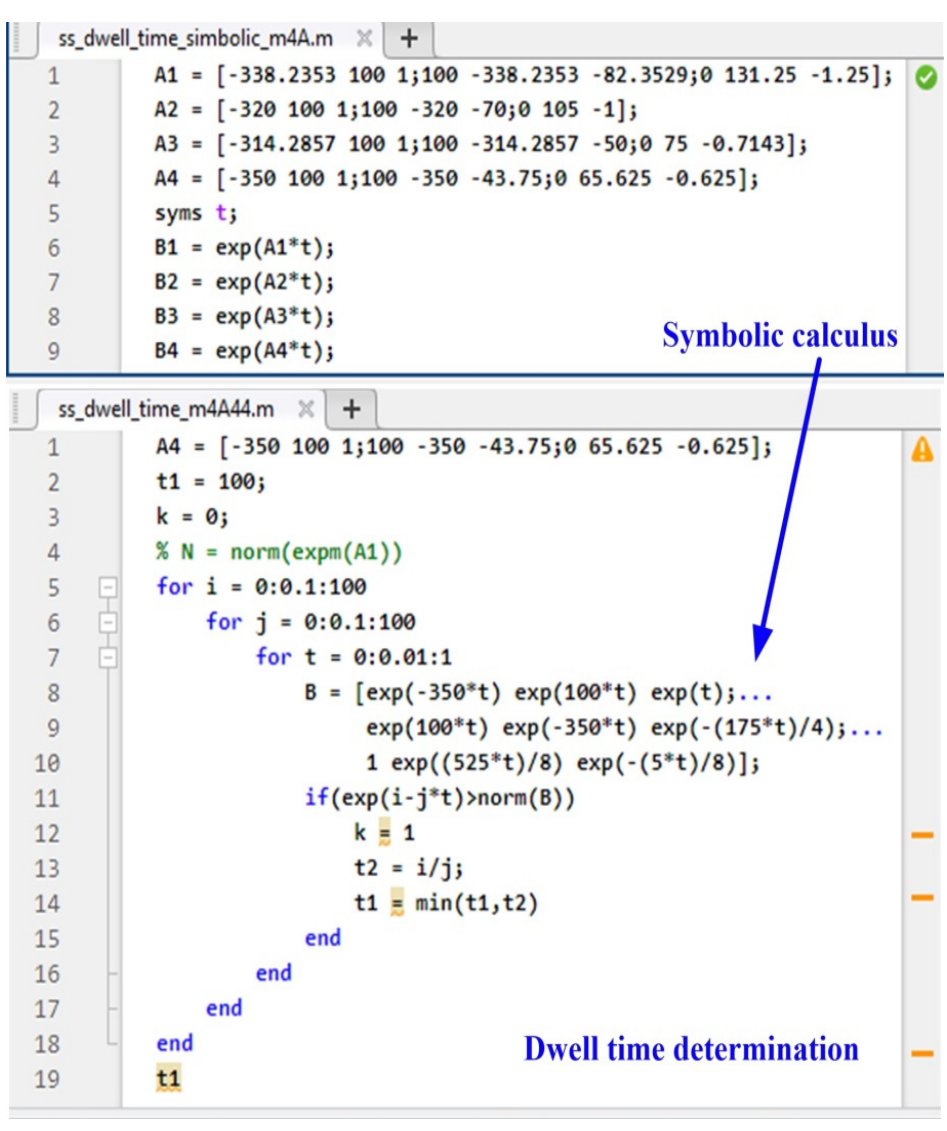
Figure 24. Matlab program for dwell time determination—variable structure 2.